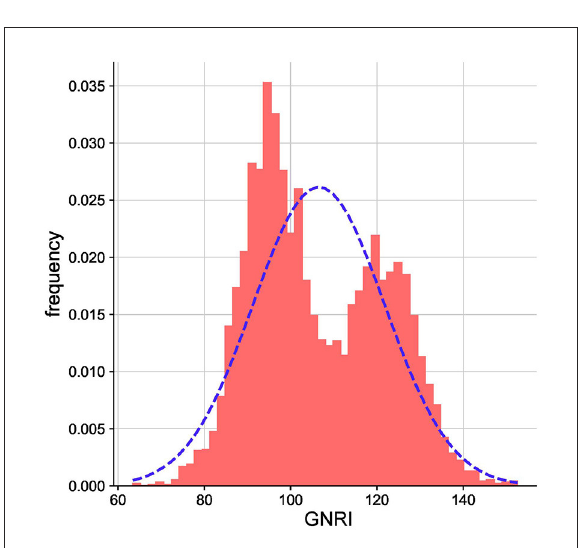
FIGURE2 Distribution of GNRI among